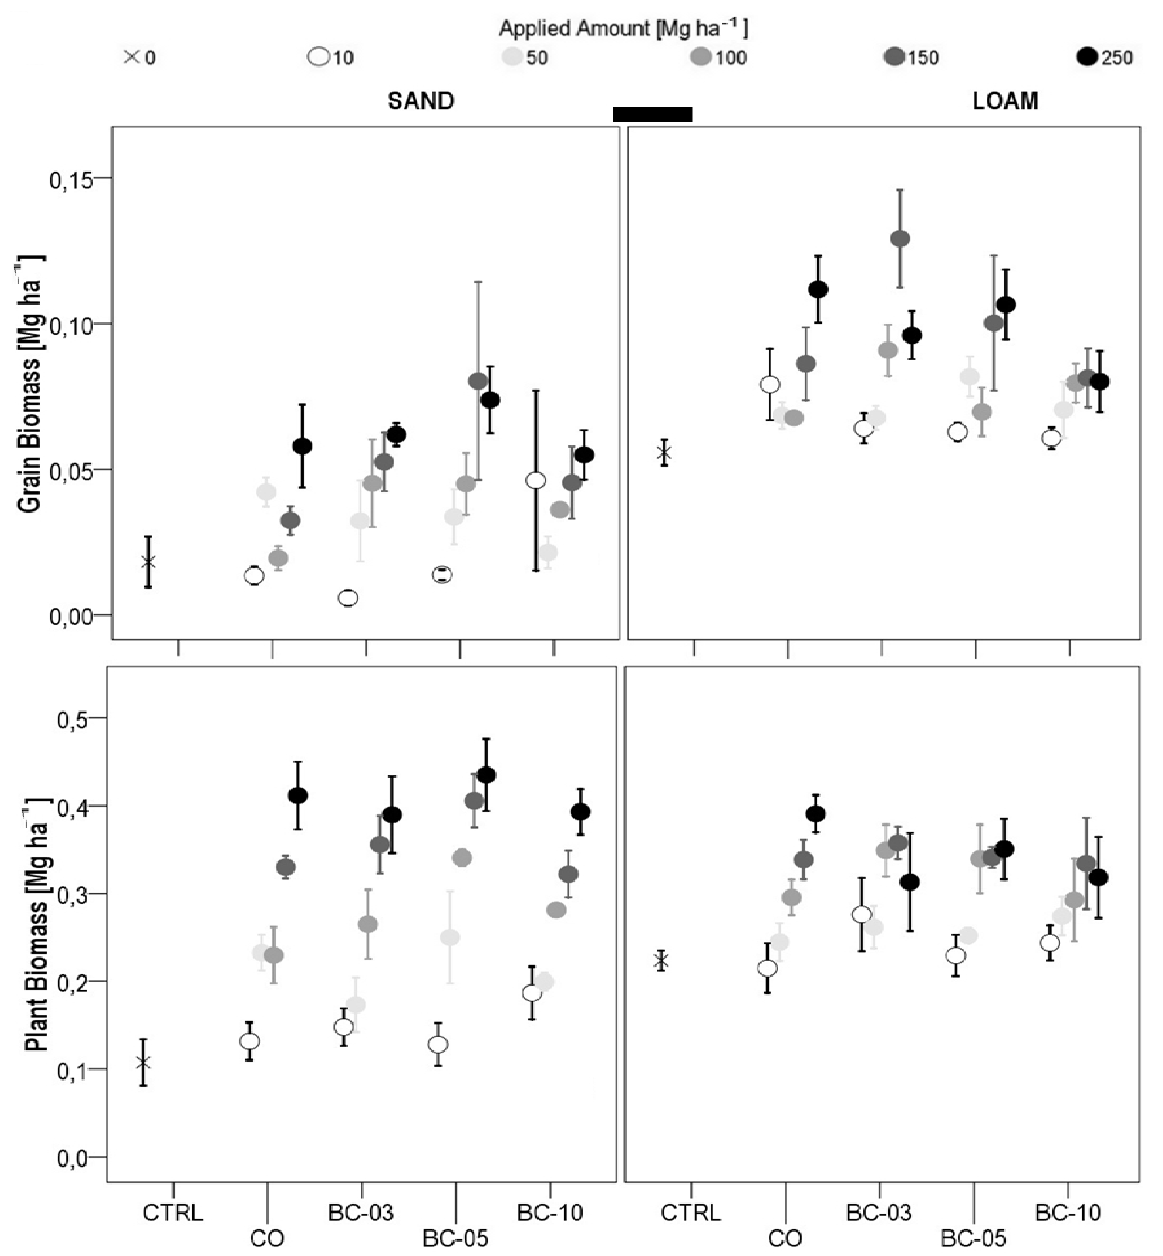
Figure 2. Grain biomass ( top ) and plant biomass ( bottom ) of oat (Avena sativa L.) in Mg ha −1 on sandy ( left ) and loamy substrate ( right ) depicted for five treatments (CO = pure compost, BC-03 = compost with 3 kg Mg −1 w / w biochar, BC-05 = compost with 5 kg Mg −1 w / w biochar, BC-10 = compost with 10 kg Mg −1 w / w biochar, in five application amounts (10, 50, 100, 150, 250 Mg ha −1 ) versus control (CTRL = no amendment) ( n =